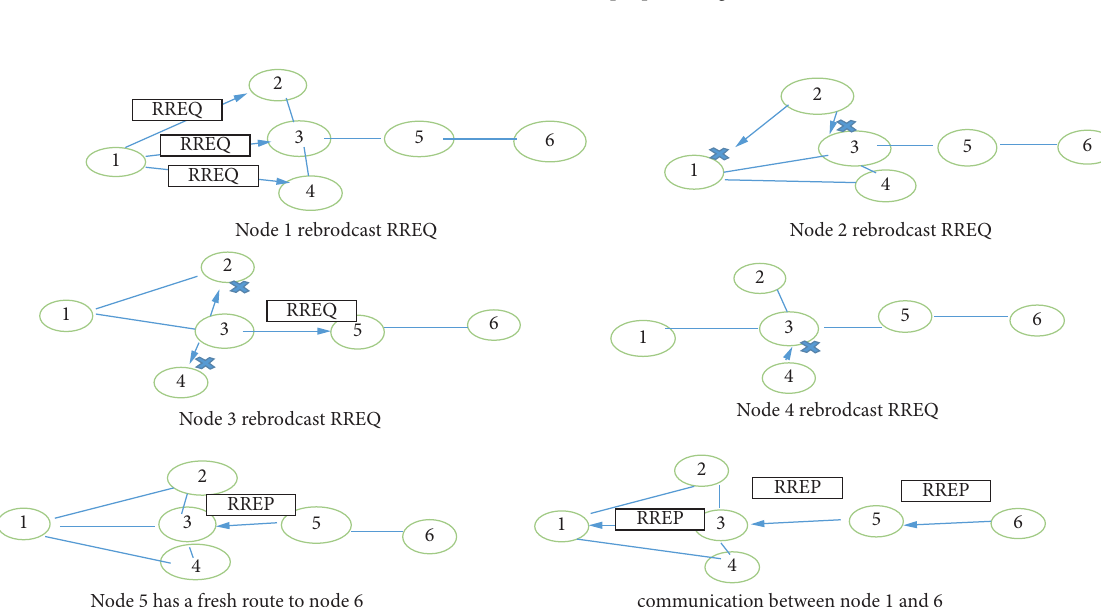
Figure 2: Te fowchart of the proposed algorithm.